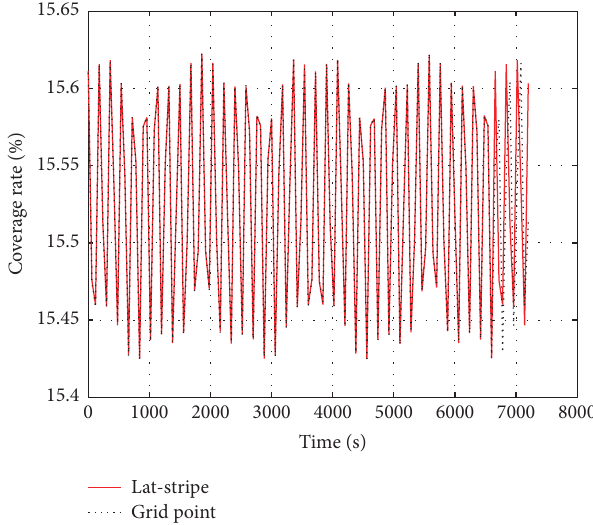
Figure 6: The variation of coverage rate when division granularity is 0.1 ∘